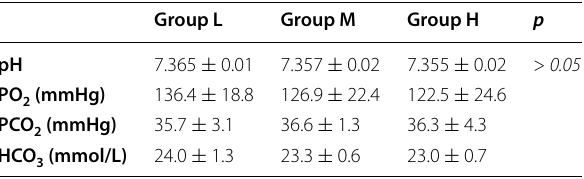
Table 3 Presentation of mean arterial blood gases parameter recordings (mean SD) for three different sugammadex dose ± groups through experiment. There was no significant statistical